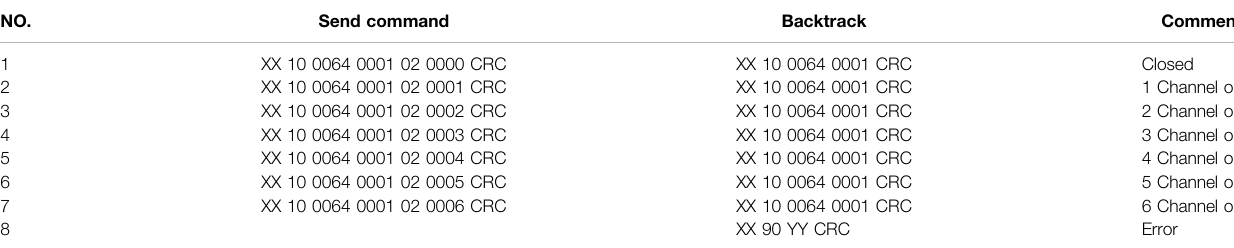
TABLE 2 | Operational order.